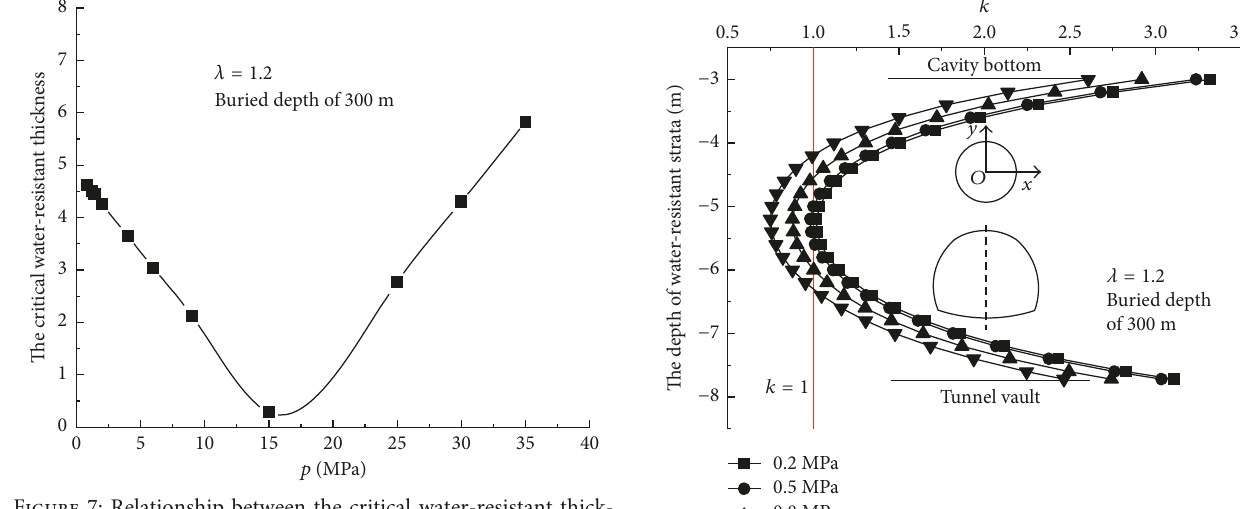
Figure 7: Relationship between the critical water-resistant thick- ness and p based on the Schwarz alternating method and Griffith strength criterion.